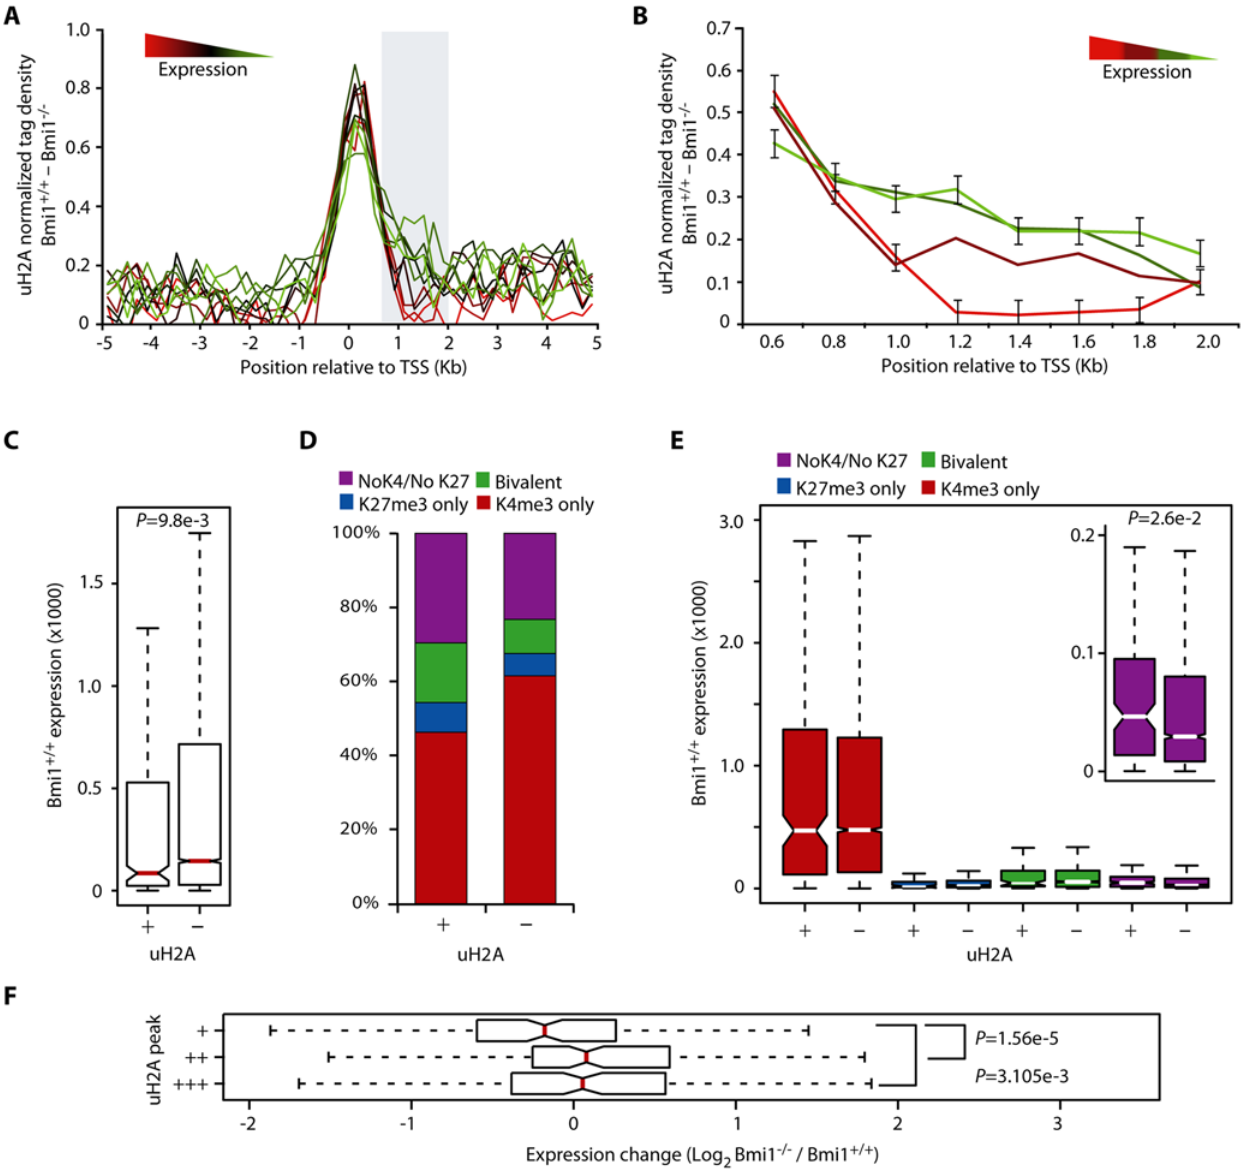
Figure 5. Bmi1-dependent uH2A is enriched at repressed genes. (A) Bmi1-dependent uH2A tag density surrounding the TSSs of genes was calculated and grouped into 10 bins ( n < 1335 for each group) based on de novo gene expression levels in MEF cells. (B) Bmi1-dependent uH2A tag density was calculated for the region indicated in (A) for genes grouped based on de novo expression in MEF cells ( n =4007, n =2674, n =2668, n =4005; highest expressed to lowest expressed). Error bars represent the s.e.m. of the highest expressed and lowest expressed gene groups. (C) WT MEF expression of genes with ( + , n =483) and without ( 2 , n =12,871) a peak of Bmi1-dependent uH2A was subjected to data distribution analysis by standard box plot. Red lines indicate median values. P value derived from Wilcoxon signed-rank test is indicated. (D) Gene promoters with ( + ) and without ( 2 ) peaks of uH2A were analyzed for the presence of H3K4/H3K27 methylation peaks. No K4/No K27, purple; both H3K4me3 and H3K27me3 (Bivalent), green; H3K27me3 only, blue; H3K4me3 only, red. (E) Box plot of expression data distribution for promoters with ( + ) and without ( 2 ) uH2A peaks in WT MEFs were further sub-divided by H3K4/H3K27 co-localization. No K4/No K27, purple; both H3K4me3 and H3K27me3 (Bivalent), green; H3K27me3 only, blue; H3K4me3 only, red. White lines indicate median values. P value derived from Wilcoxon signed-rank test is shown. (F) Genes containing a peak of Bmi1-dependent uH2A were divided into three groups based on increasing peak tag density ( n =157, 157, and 158, respectively) and the distribution of log 2 expression change (Bmi1 null versus WT MEF cells) was presented by box plot. Red lines indicate median values. P value derived from Wilcoxon signed-rank test is shown. The correlation between increased levels of uH2A and gene peaks to those without peaks in terms of their association with repression could be due to an intrinsic repressive effect of uH2A promoter H3K4me3 or H3K27me3 marks. This analysis revealed that a higher proportion of genes containing uH2A are also on transcription or due to an association of uH2A with other silencing epigenetic marks. To differentiate between these marked by H3K27me3 either alone or in the context of bivalent possibilities, we compared genes with promoter uH2A enrichment domains when compared with genes not marked by uH2A